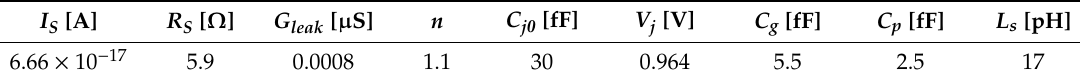
Figure 2. Equivalent circuit model of diode. ( a ) Single anode and ( b ) three anodes in series. Table 1. Equivalent circuit parameters of three ‐ anode diode.